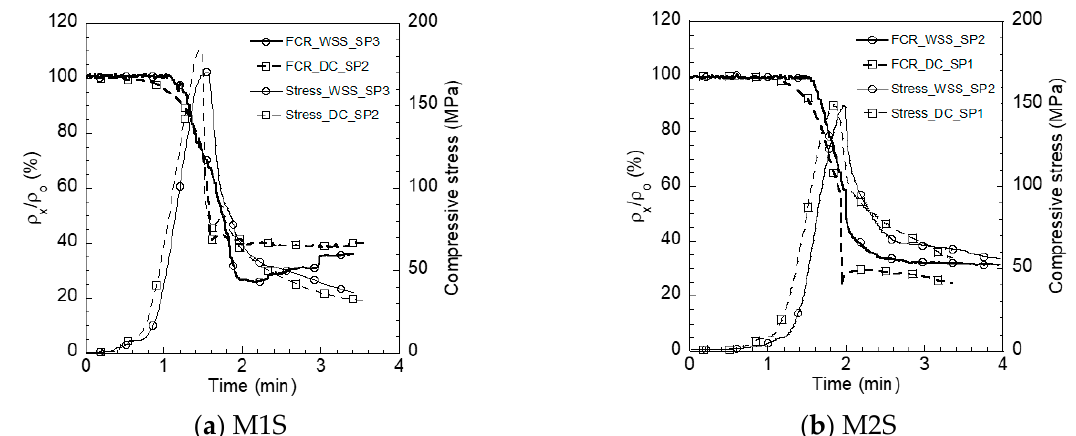
Figure 14. Electrical resistivity response of S-UHPCs under compression.